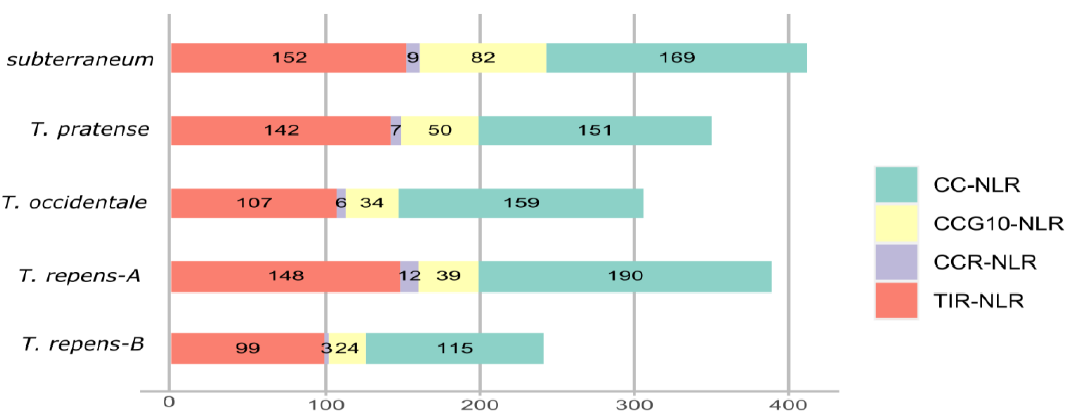
Figure 1. Horizontal bar graph exemplifies the organization of NLR genes that include four significant sub-class denoted in four different colors.